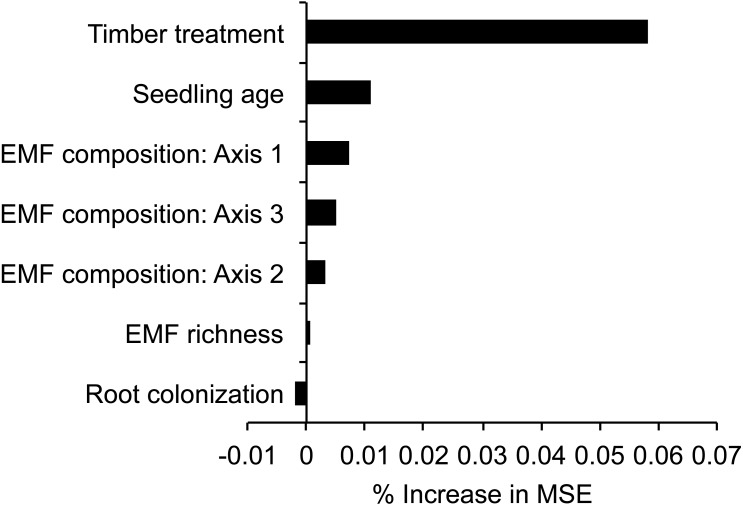
Variable importance scores based on Random Forest regression trees explaining seedling biomass in relation to variable retention timber management treatment, seedling and fungal variables.Scores are derived from the increase in the mean square error (% increase MSE) when a variable is permuted. Axis1, 2, and 3 were derived from NMDS ordination of EMF composition of each seedling. Variable retention treatment and seedling age were more important predictors of seedling biomass than EMF variables.